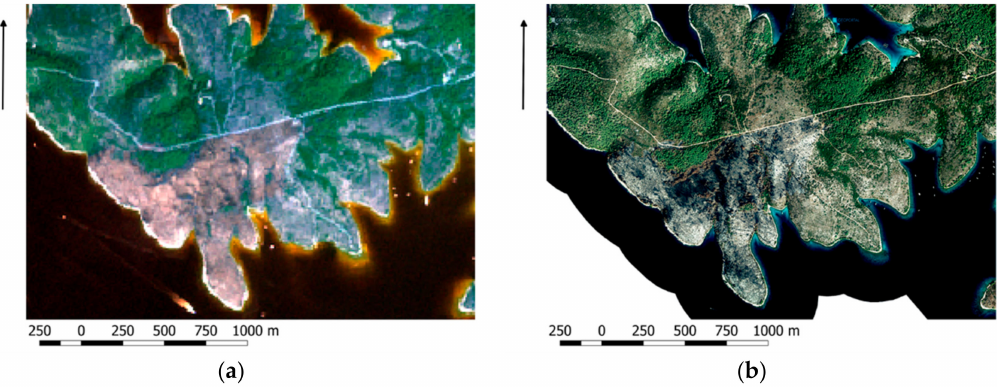
Figure 4. Case study area of Cape Kabal (source: Amazon S3 and SGA Geoportal): ( a ) Sentinel image from 31 August 2017; ( b ) Digital orthophoto image from